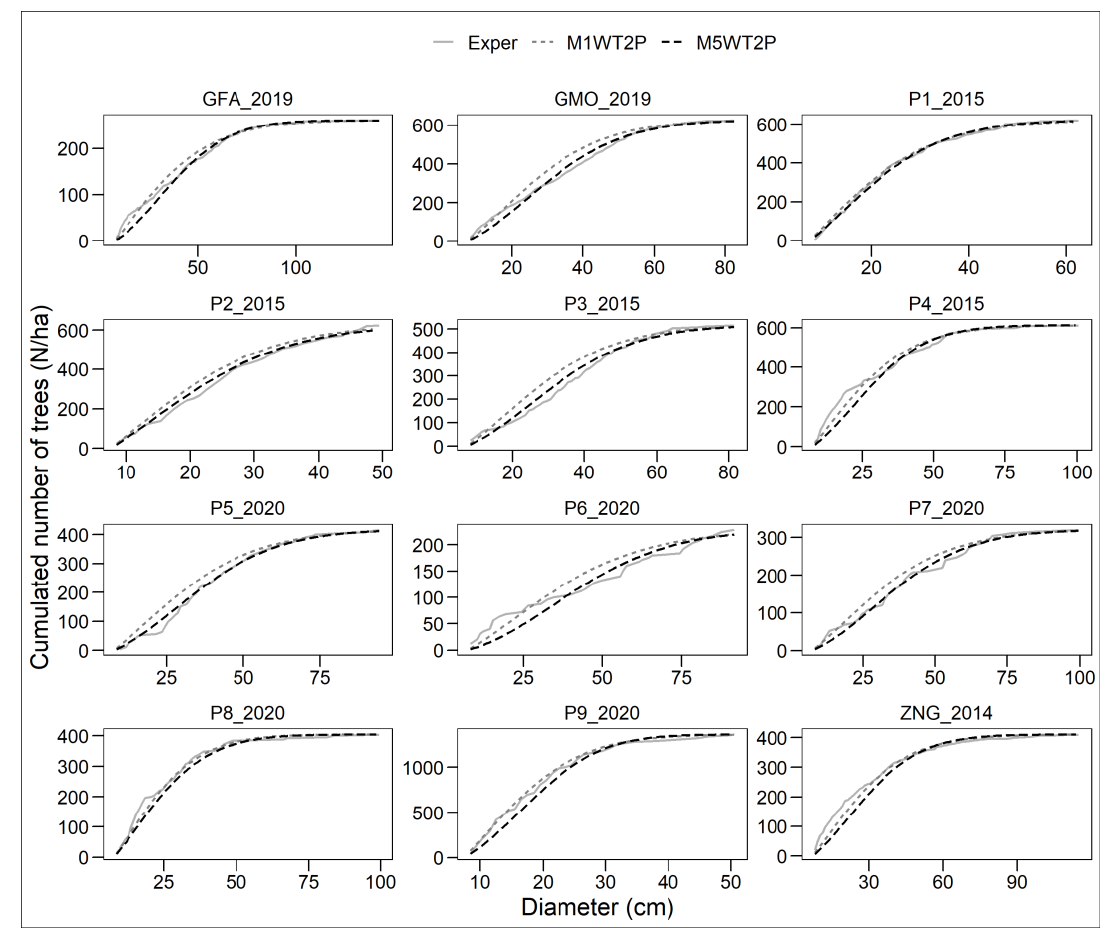
Figure 4. Example of the fitted distribution for 12 plots of the test dataset. Here the Exper represents the experimental distribution, M1WT2P is the M1 modeling approach using the left-truncated Weibull distribution (WT2P), which achieved the last ranking position for both the fitting and the test dataset; M5WT2P is the M5 modeling approach using the left-truncated Weibull distribution (WT2P) which ranked first for both the fitting and the test dataset.